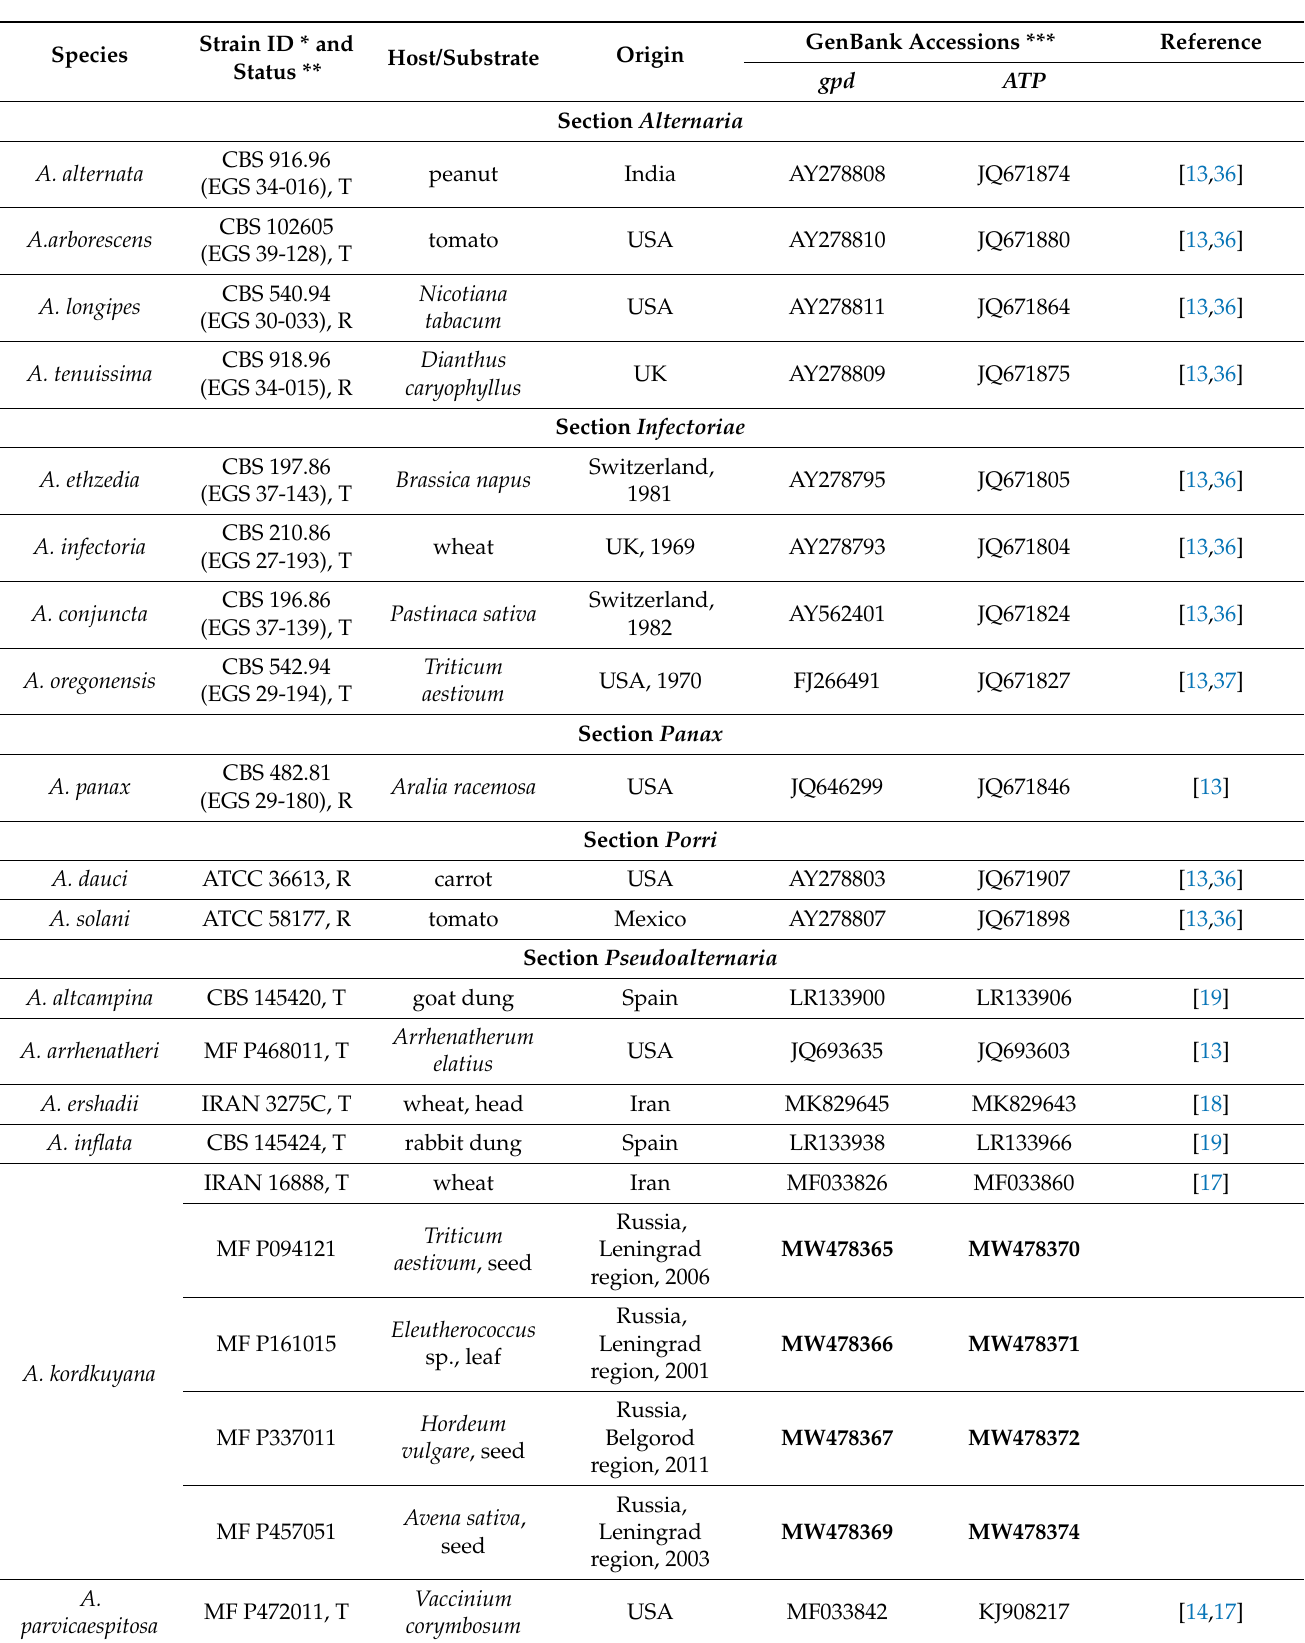
Table 2. Alternaria spp. sequences used for phylogenetic study and primer